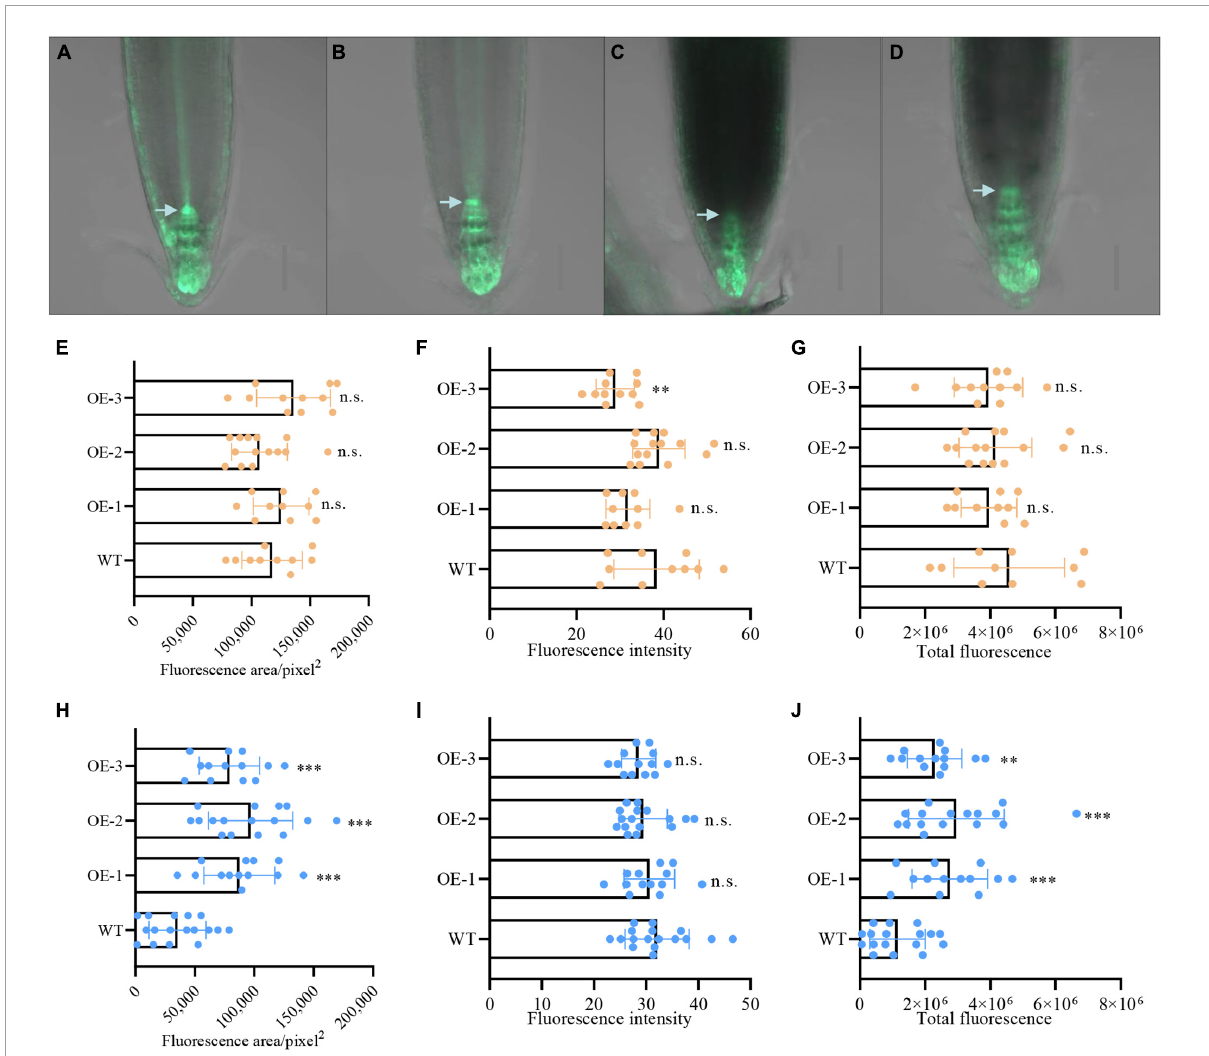
FIGURE7 NbCIPK25 contributes to auxin distribution at the root meristem under salt stress. (A–D) Green fluorescence indicates the DR5:GFP signal in WT (A) and transgenic seedling (B) treated with 0 mM NaCl for 24 h; DR5:GFP in WT (C) and transgenic seedling (D) treated with 100 mM NaCl for 24 h; scale bar: 50 µ m; arrowheads indicate the QC. (E–G) Fluorescence area (E) , fluorescence intensity (F) , and total fluorescence (G) of the DR5:GFP signal in the 5-day-old WT and transgenic seedlings treated with 0 mM NaCl for 24 h. (H–J) Fluorescence area (H) , fluorescence intensity (I) , and total fluorescence (J) of the DR5:GFP signal in the 5-day-old WT and transgenic seedlings treated with 100 mM NaCl for 24 h. (E–J) Data represent means ± SD, three biological replicates. “ ∗∗ ” p < 0.01; “ ∗∗∗ ” p < 0.001; n.s. means no significant difference via an unpaired t